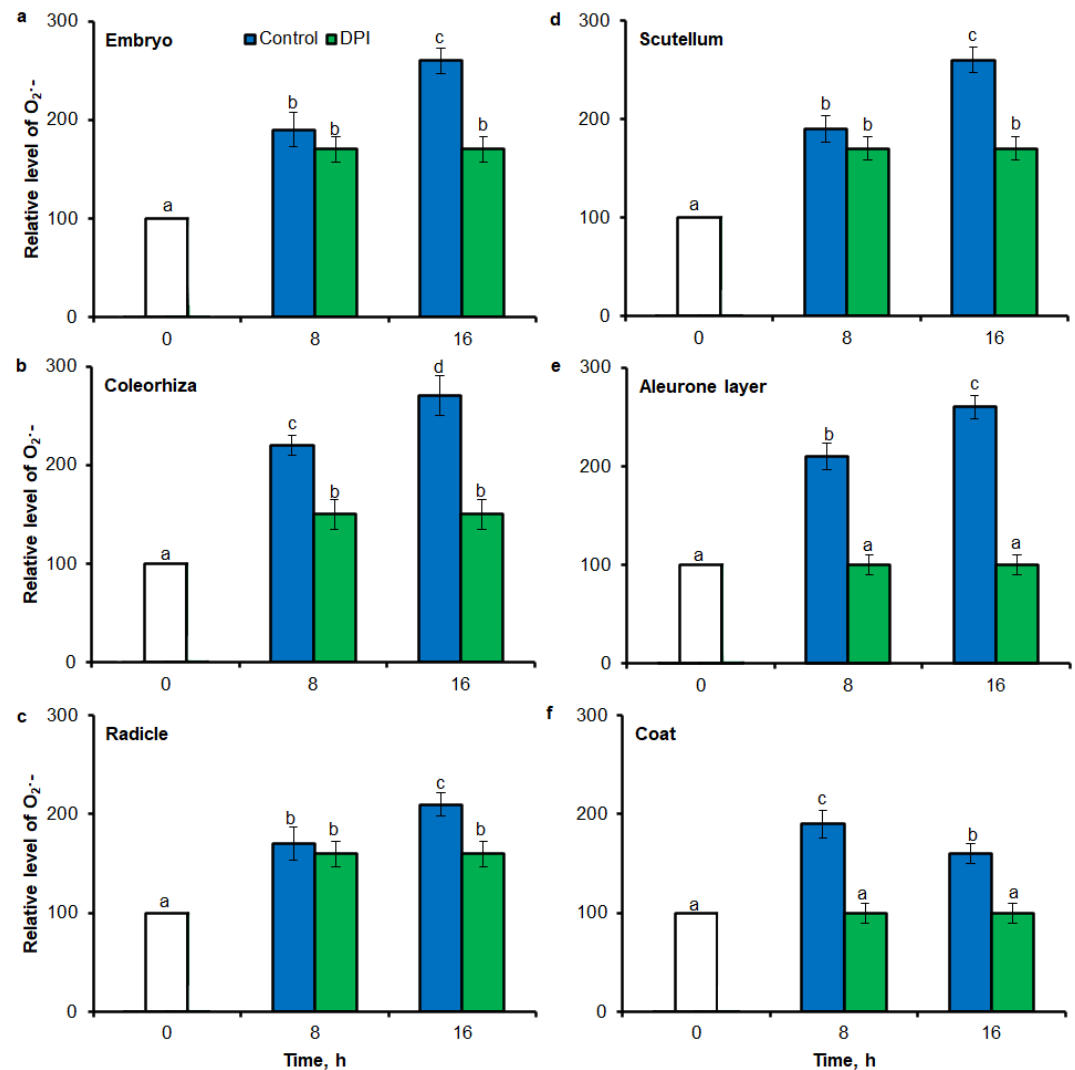
Figure 6. Quantification of O 2 •− in A. fatua embryo ( a ), coleorhiza ( b ), radicle ( c ), scutellum ( d ), aleurone layer ( e ) and coat ( f ) of seeds incubated in water or DPI (10 − 4 M) at 20 ◦ C for di ff erent time by flow cytometry (FCM). Fluorescence data are expressed as mean fluorescence intensity (percentage of control). No autofluorescence was present when samples were incubated without dye. Vertical bars indicate ± SD. One-way ANOVA with the Duncan’s post hoc test was used to determine the significance of di ff erences. Mean values with di ff erent letters (a–d) are significantly di ff erent ( p < 0.05, n = 5). Fluorescence-based signal for H 2 O 2 was also detected in di ff erent part of seed by flow (cid:48) (cid:48) cytometry (FCM), when seeds were stained using 6-carboxy-2 ,7 -dichlorodihydrofluorescein diacetate di(acetoxymethyl ester) (CDCDHFDA-AM). The fluorescence signal was more strongly in